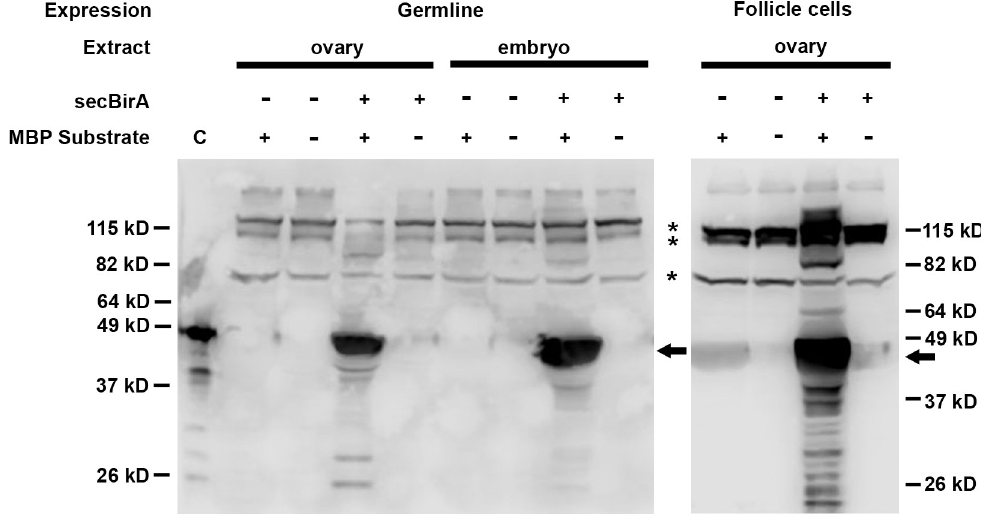
Fig 3. secBirA expressed in Drosophila ovaries and embryos exhibits biotin ligase activity. Protein extracts from ovaries and embryos expressing (+) or lacking (-) secBirA were incubated with (+) or in the absence of (-) a BirA substrate, Maltose Binding Protein fused in-frame to the Biotin Acceptor Peptide (MBP substrate). After SDS-PAGE and blotting to nitrocellulose, biotinylated MBP was detected with streptavidin-HRP. The lane at far left (labelled C) contains commercially available biotinylated MBP (bio-MBP)(Avidity LLC) as a positive control. When incubated together with substrate, extracts from ovaries and progeny embryos of females expressing secBirA in the germline, and extracts of ovaries from females expressing secBirA in the follicle cell layer, exhibited a strong signal corresponding to biotinylated MBP (see arrows).